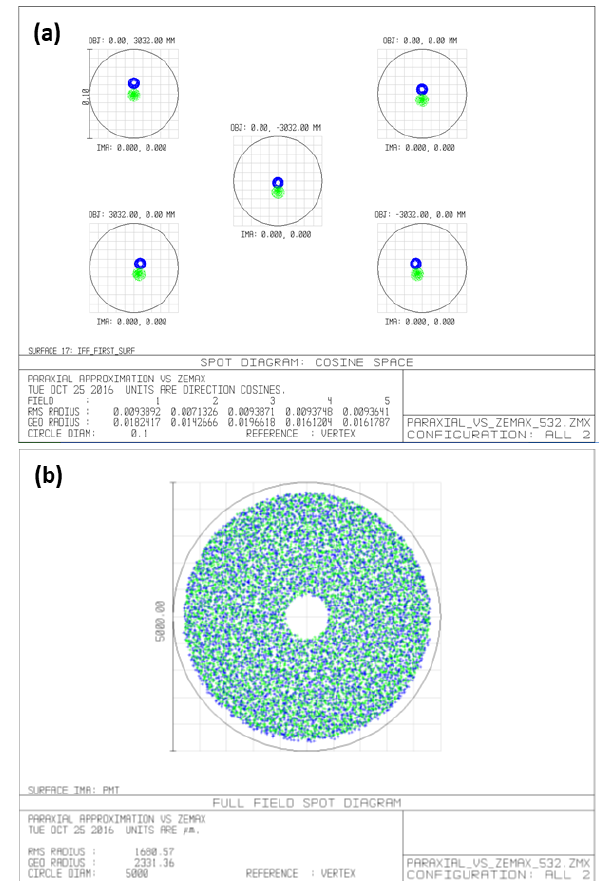
Figure 4. Spot diagrams of far- (green; 10000m) and near- (blue; 257m) range rays on the (a) front surface of the IFF from five differ- ent positions within the receiver field of view, and (b) PMT detector with 5mm effective diameter (black